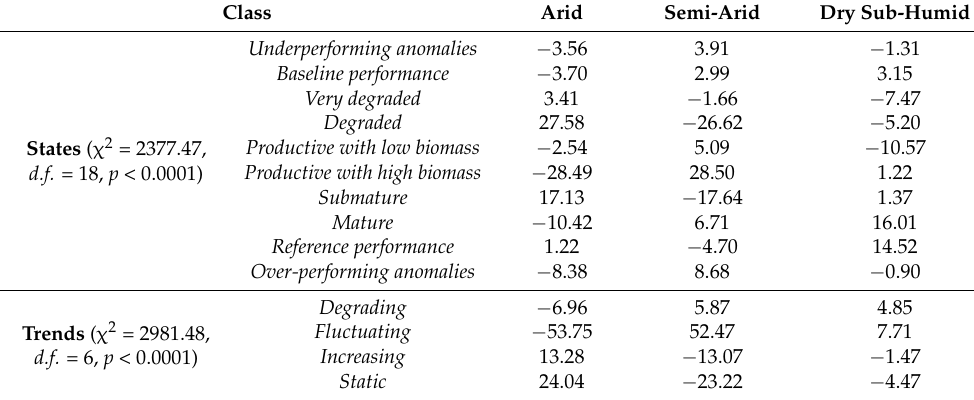
Table 3. Associations of land condition states, land condition trends and aridity zones (dry lands) found using two chi-square tests. Inputs are adjusted residuals (corrected for sample size), expressing differences between observed frequencies and expected frequencies under the null hypothesis of a random distribution. Values are standard deviation units and can be tested as z-scores using a normal distribution. A threshold of ˘ 1.96 was used to determine